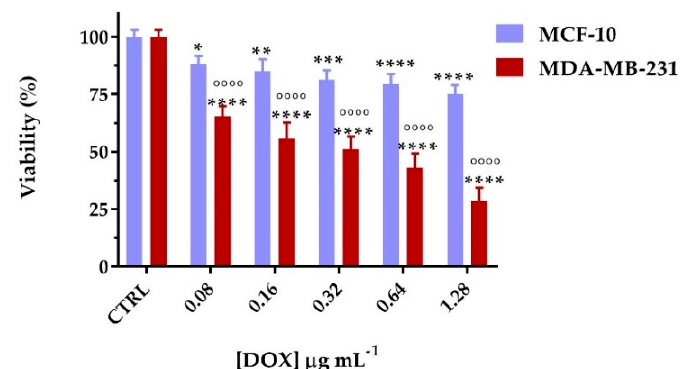
Figure 9. Cell viability of MCF-10A and MDA-MB-231 cells treated with DOX@DFNPs (drug concentration ranging from 0.08 to 1.28 µ g mL − 1 ) after 72 h of culture. * p < 0.05, ** p < 0.01, *** p < 0.001, and **** p < 0.0001 vs. each control (CTRL); ◦◦◦◦ p < 0.0001 vs. the same drug equivalent concentration on MCF-10A (two-way ANOVA followed by Tukey’s post-test; data are expressed as mean ± SD of three independent experiments).